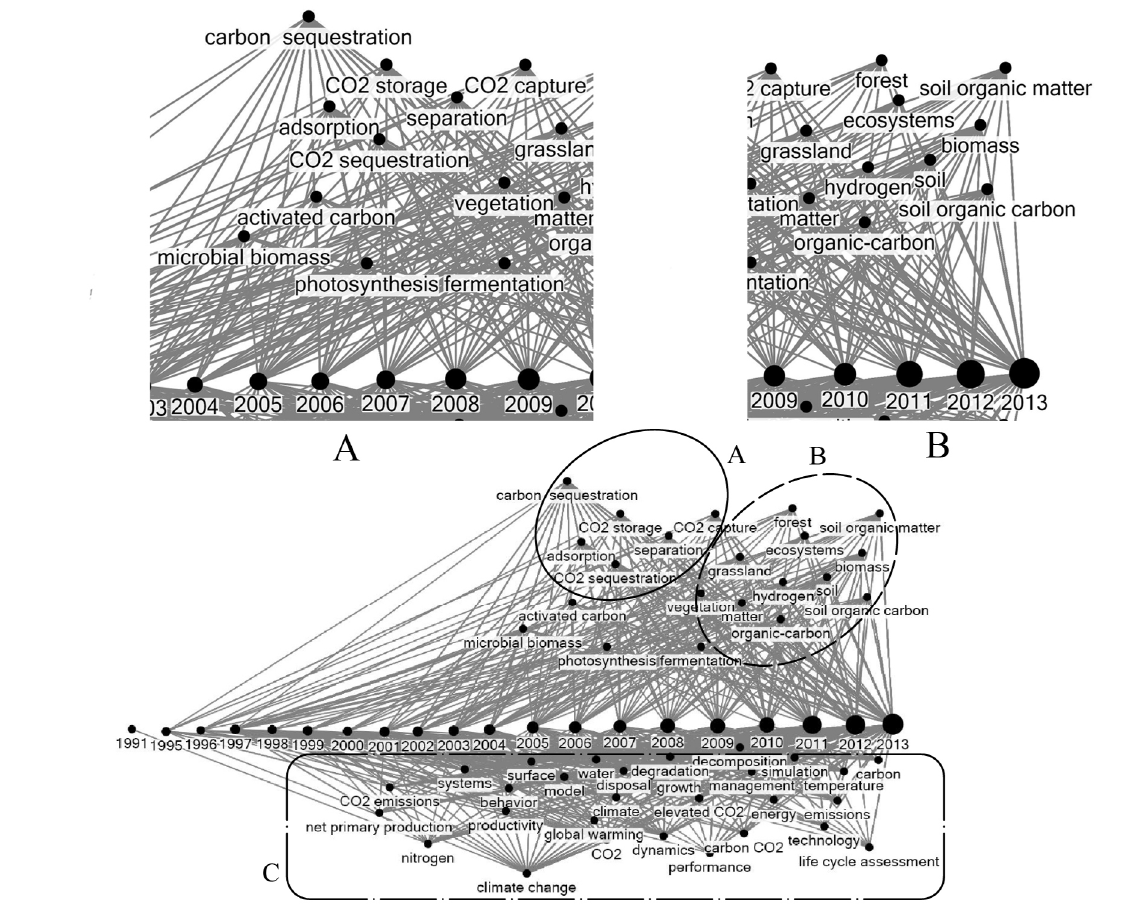
Figure 6. Keywords focus trend of geothermal energy